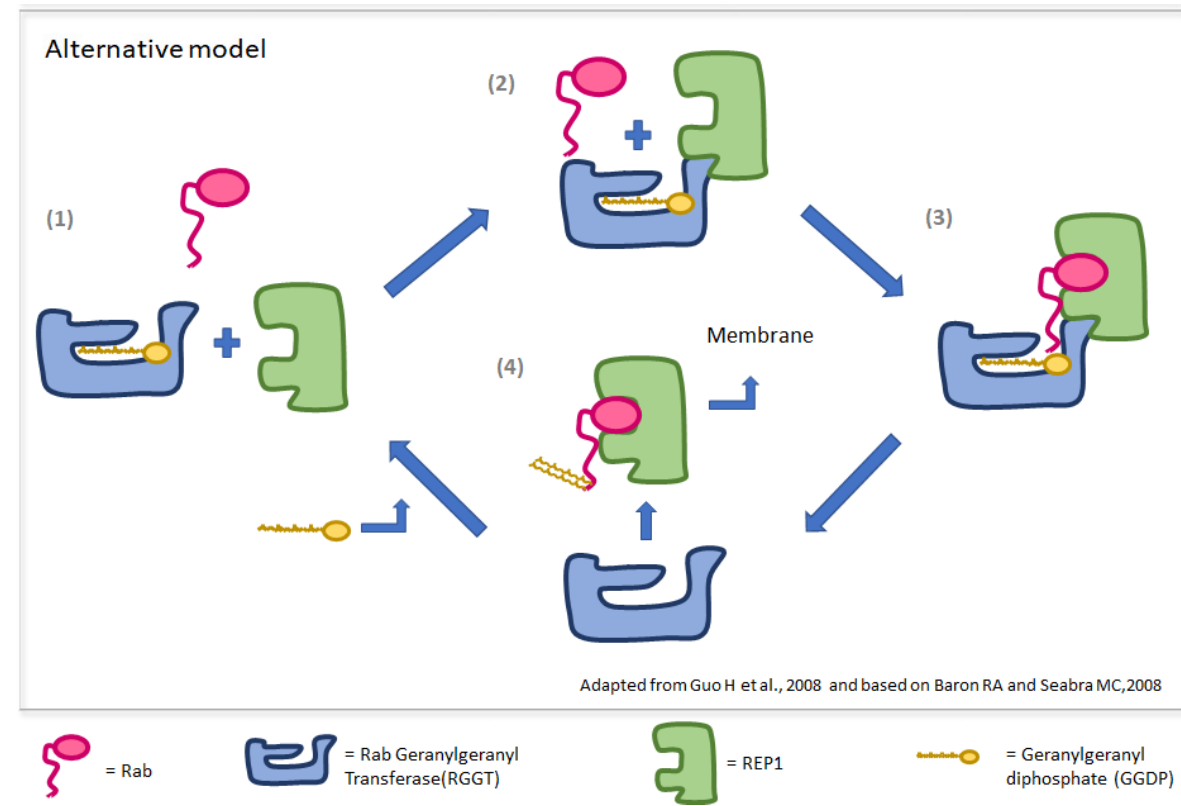
Figure 1. Models of REP1 mediated prenylation of Rab proteins. (Upper panel). Traditional model: (1) REP1 binds Rab; (2) Rab/REP1 complex binds RGGT/GGDP; (3) RGGT mediates two cycles of geranylation of Rab using two molecules of GGDP; (4) REP1 detaches from RGGT and escorts RabGG to membranes. (Lower panel). Alternative model: (1) REP1 binds RGGT/GGDP; (2) Rab binds REP1/RGGT/GGDP complex; (3) RGGT mediates two cycles of geranylation of Rab using two molecules of GGDP; (4) REP1 detaches from RGGT and escorts RabGG to membranes.